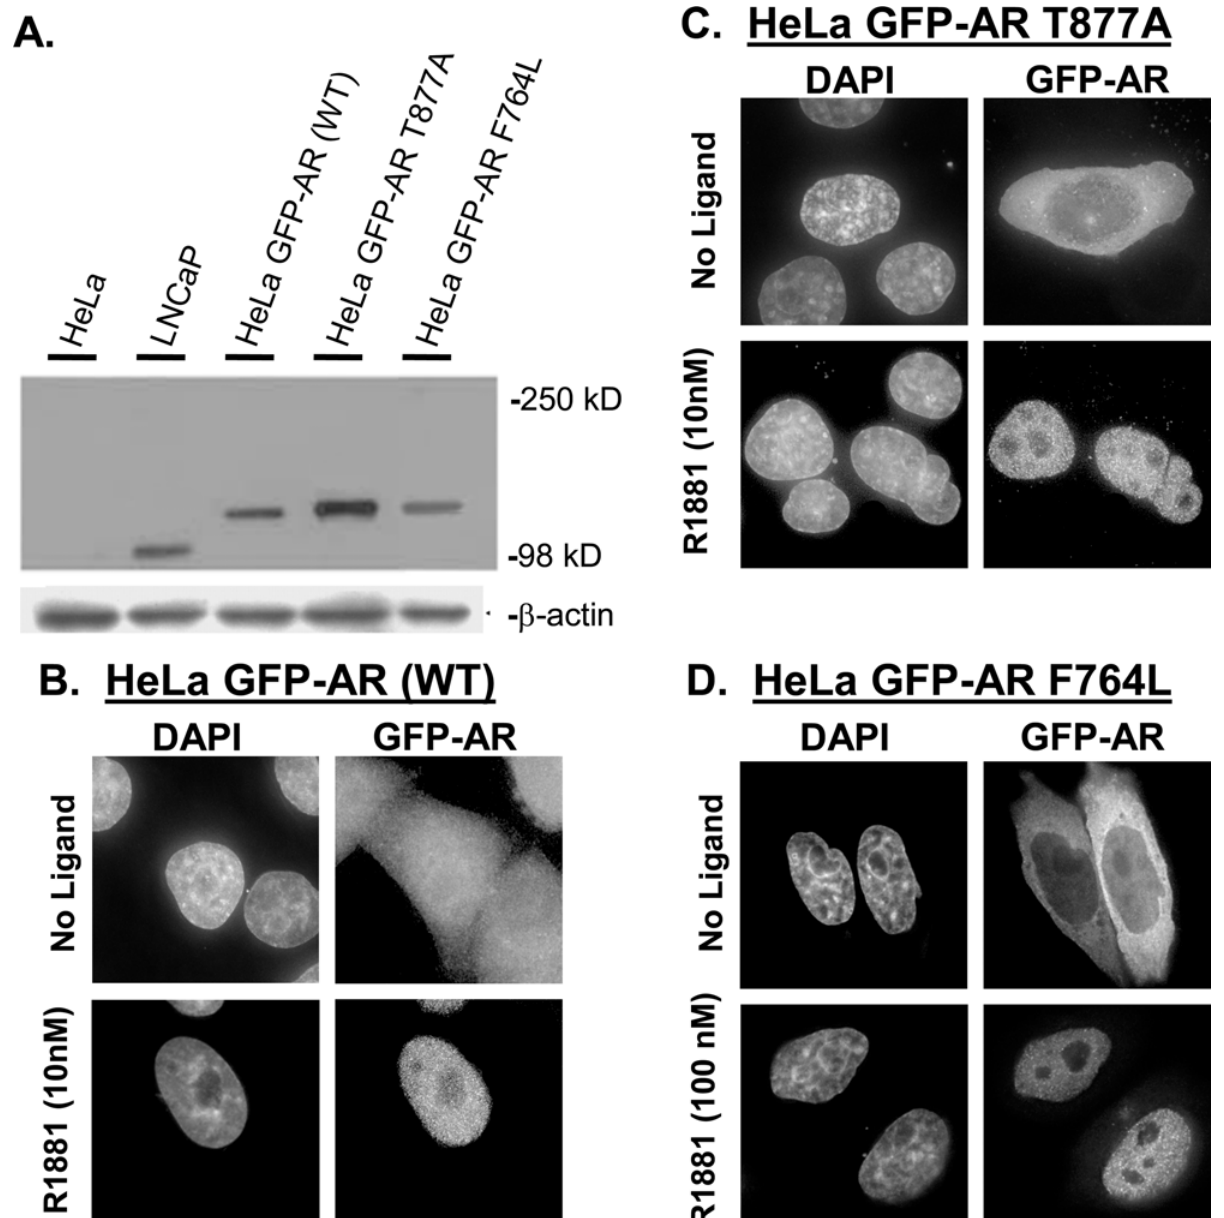
Figure 1. HeLa GFP-AR cell lines expressing wild type and mutant AR able to translocate into nucleus in response to agonist. A. Western blot analysis comparing HeLa (1), LNCaP (2), HeLa GFP-AR (3), HeLa GFP-AR T877A (4), and HeLa GFP-AR F764L (5) androgen receptor expression. Equal total protein levels were loaded for all cell abstracts and confirmed with b -actin control. B, C, and D. Deconvolution images of HeLa cell lines expressing stably integrated GFP-AR, GFP- AR T877A (LNCaP, ligand binding domain mutation), and GFP- AR T877A (AIS associated mutation, ligand binding domain mutation), shown without (top) and with 10 nM or 100 nM R1881 (bottom). The LBD mutation in GFP-AR T877A or GFP-F764L does not affect the ability to translocate into the